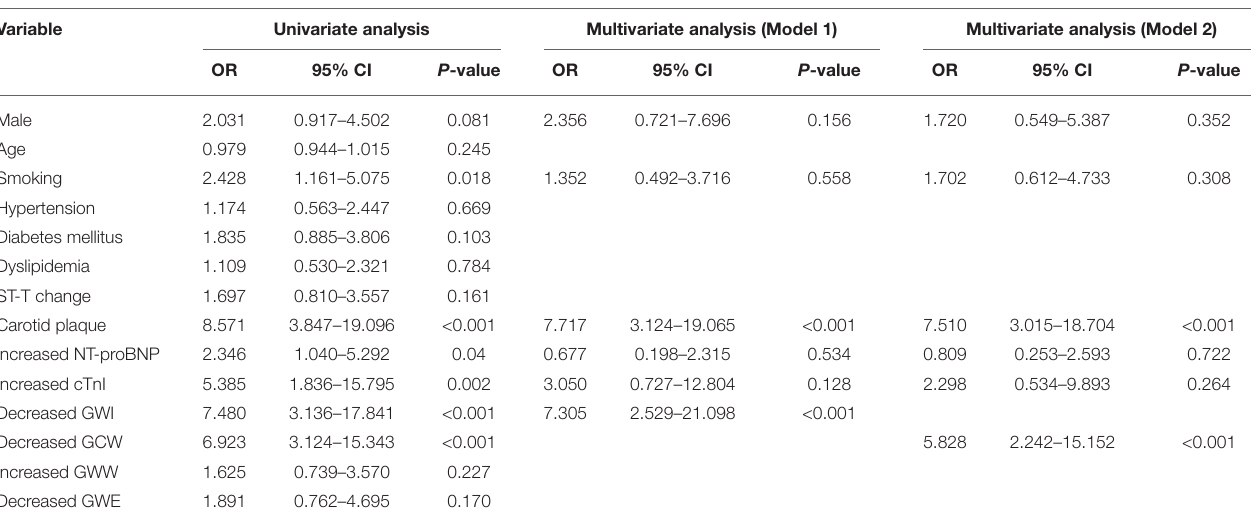
TABLE 6 | Univariate and multivariate analyses of risk factors for high-risk